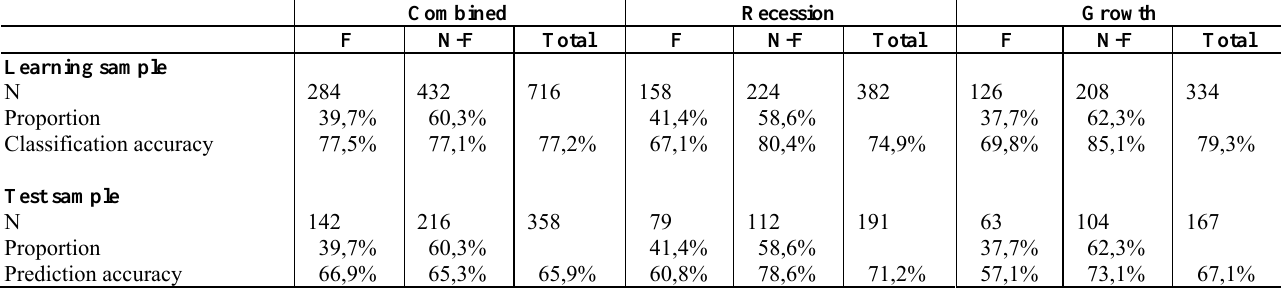
Table 6: Proportions of failed (F) versus non-failed (N-F) companies in the populations and classification - and prediction accuracy of the models